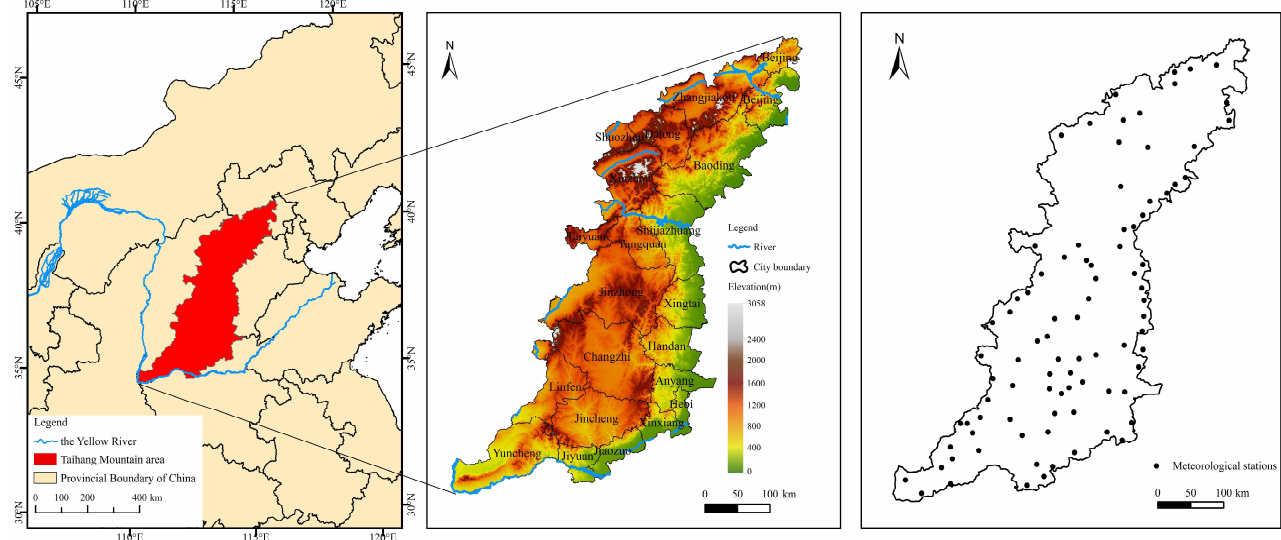
Figure 1. Locations of the Taihang Mountain study area and the meteorological